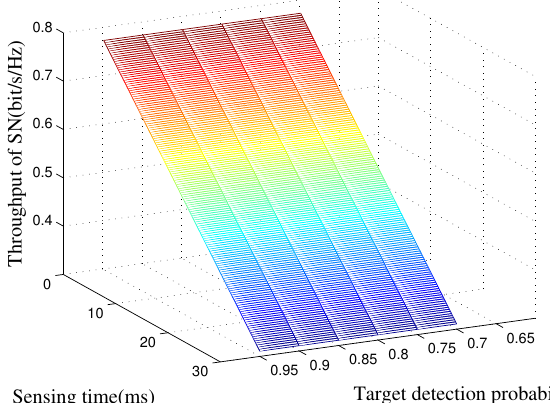
Figure 3. SN’s average throughput of the proposed strategy as a function of the spectrum sensing time and target detection probability. The spectrum idle probability is set to P ( H 0 ) , the transmit power of the PT is set to P b = 15 dB, and the target secure outage probability is set to P th =